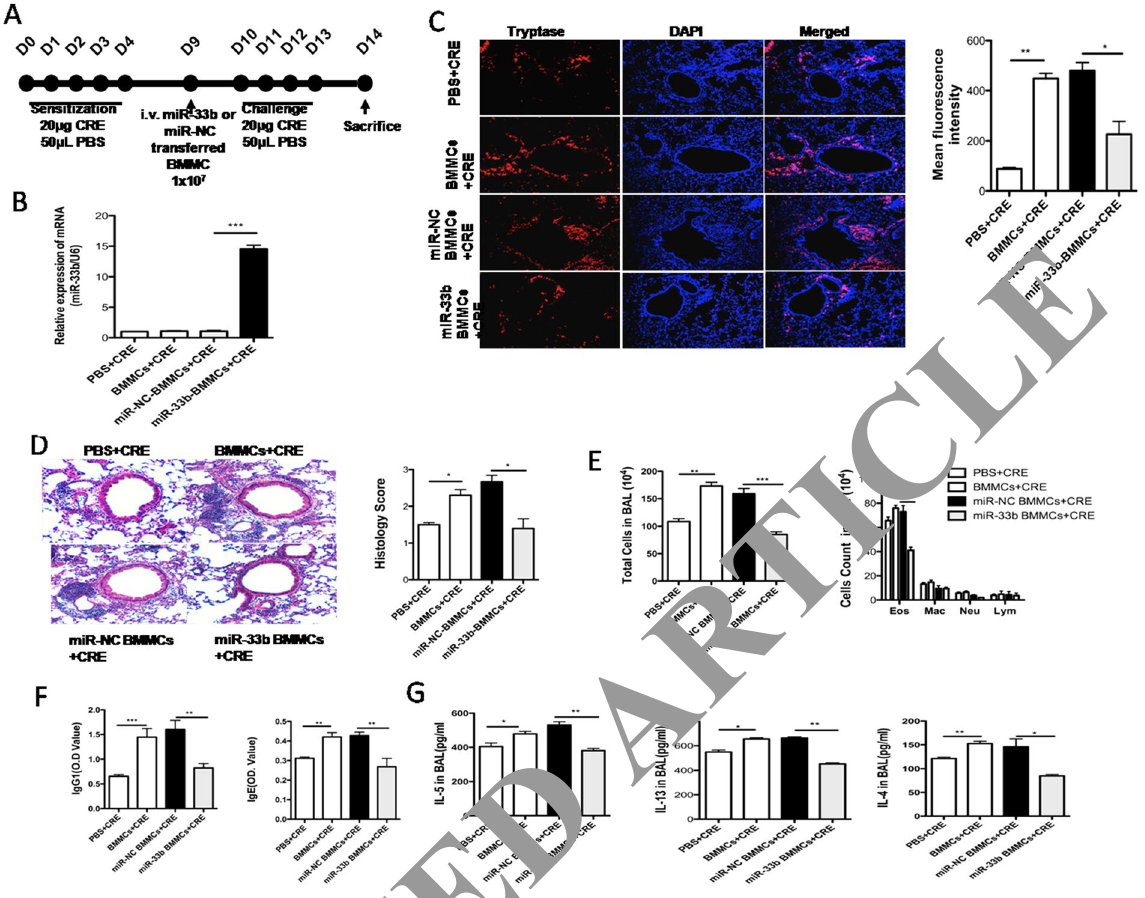
Figure 7. MiR-33b inhibits lung inflammation in mice engrafted with miR-33b BMMCs. ( A ) Protocol for the adoptive transfer of BMMCs in the cockroach allergen-induced mouse model of asthma. ( B ) qRT-PCR was used measure miR-33b expression. ( C ) Tryptase expression and quantities in the lung sections of CRE- challenged C57BL/6 mice with adoptively transferred miR-NC or miR-33b BMMCs. ( D ) Representative H&E- stained paraffin lung tissue sections from C57BL/6 (n = 6) that were adoptively transferred with miR-NC or miR-33b BMMCs in the CRE-induced mouse model of asthma. ( E ) Cellular inflammation as indicated by the total cell numbers and differentiated leukocyte cell numbers in the BALF. ( F ) The specific IgE and IgG1 levels of the transfected mice were determined using ELISA assays. ( F ) The Th2 cytokines IL-4, -5 and -13 were measured in the transfected mice model. The data are representative of three independent experiments (n = 4–6 mice/group). The data are presented as the means ± SEM. * P < 0.05, ** P < 0.01, *** P <